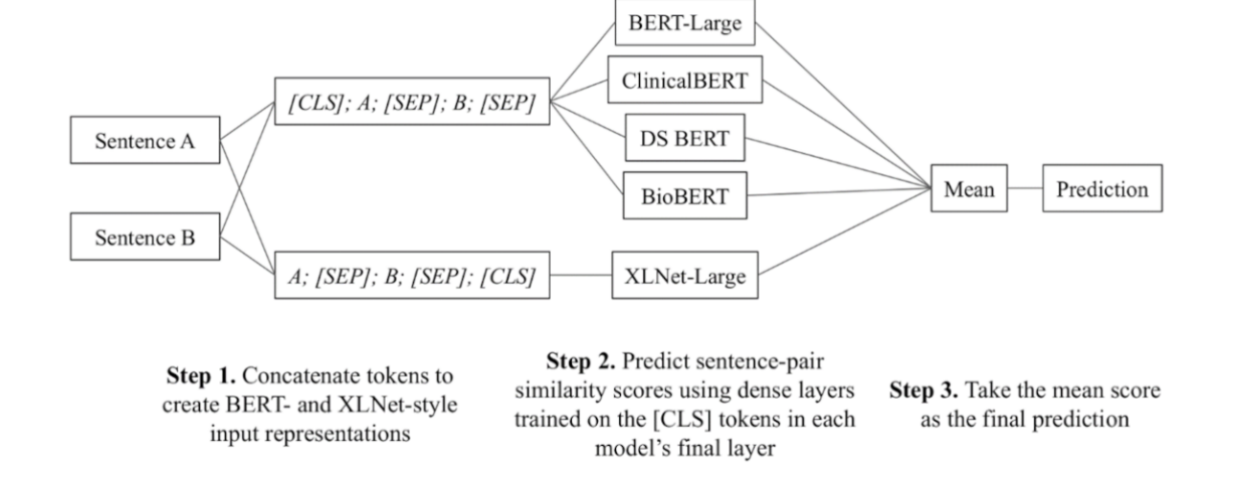
Mean scoreXLNetDS BERTClinicalBERTBioBERTBERTModel